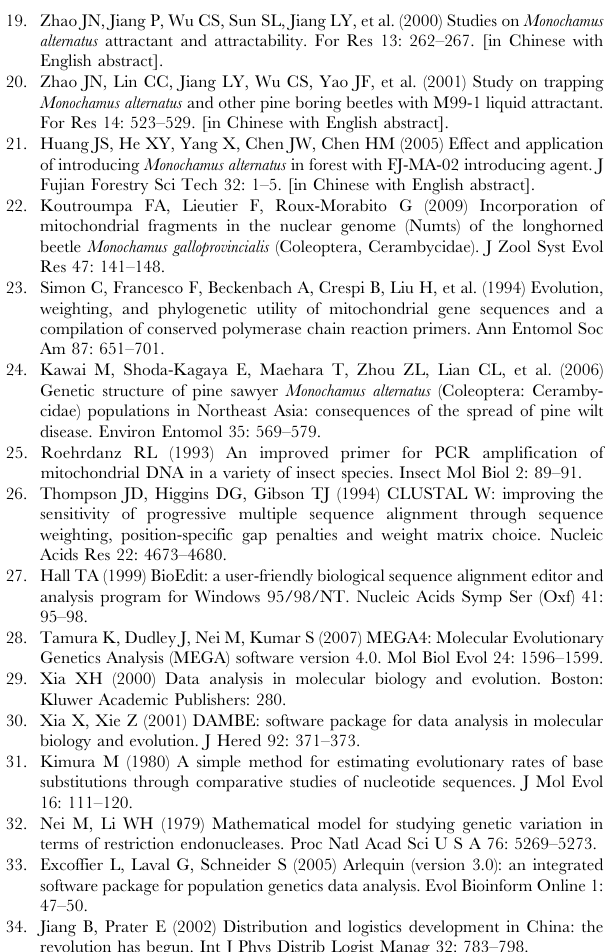
Table S1 Results of AMOVA analyses with significance based on different grouping criteria of regional freight turnover (RFT) in China (see text for details). Table S2 Matrix of the gene flows ( N m ) (above diagonal) and the Kimura two-parameter (K2P) distances (below diagonal) among 14 populations of M. alternatus from mainland China. Table S3 Nei’s average number of pairwise differences between populations (above diagonal), Nei’s average number of pairwise differences within populations ( K ) (diagonal elements), the pairwise F st values (below diagonal), and the nucleotide diversity (the last row) of the 14 populations of M. alternatus from mainland